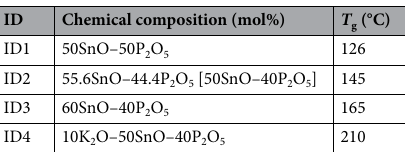
Table 1. Chemical compositions and the glass transition temperature ( T g ) values of SnO–P 2 O 5 -based